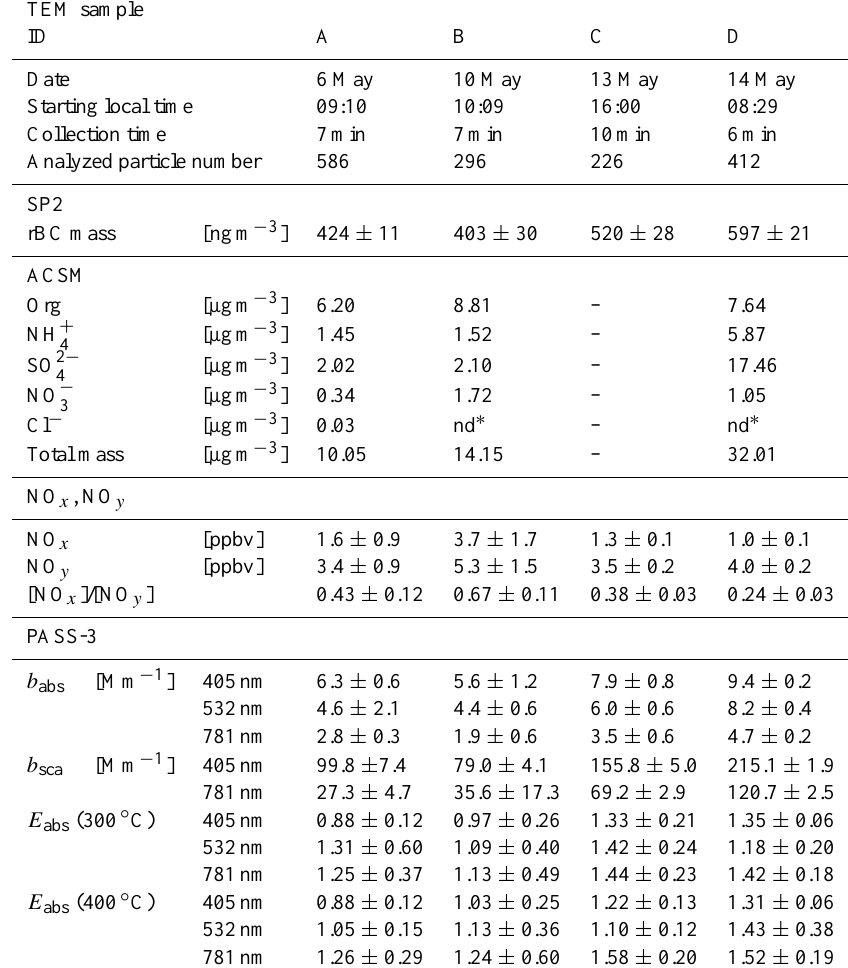
Table 2. TEM samples used in this study, and rBC, NO x , and NO y concentrations and optical parameters (average values ± standard deviation) during the sampling